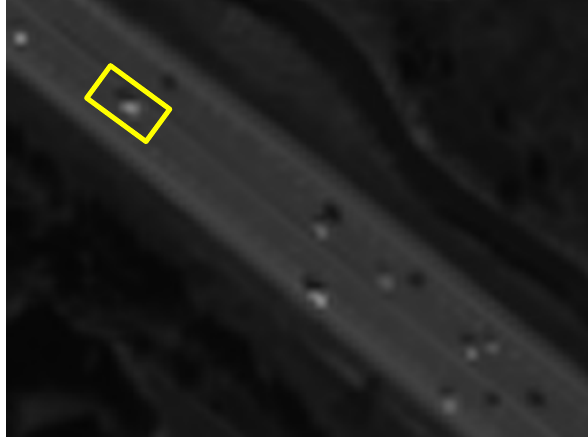
Figure 2: Second principal component of MS-1 image (MS-1: